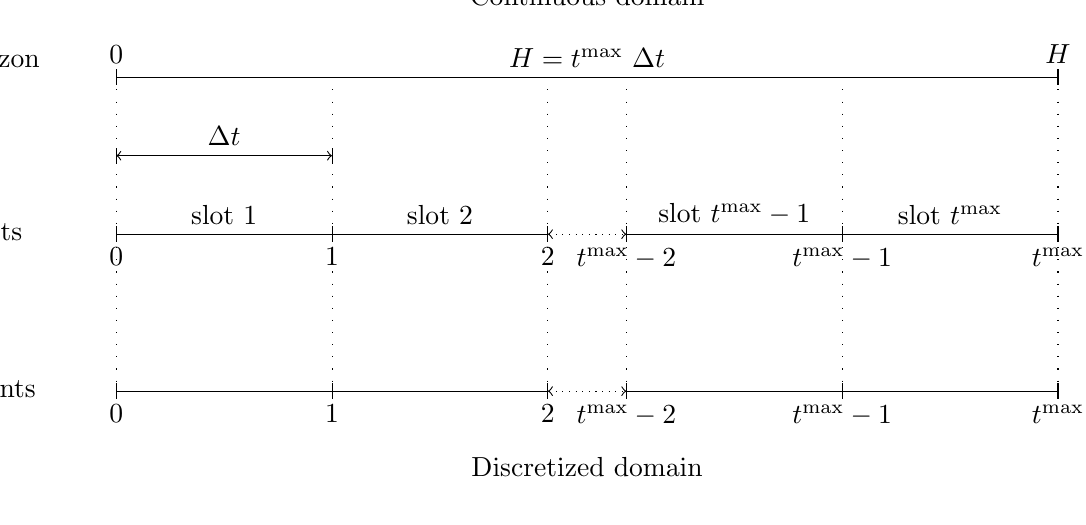
Figure 1. Time discretization